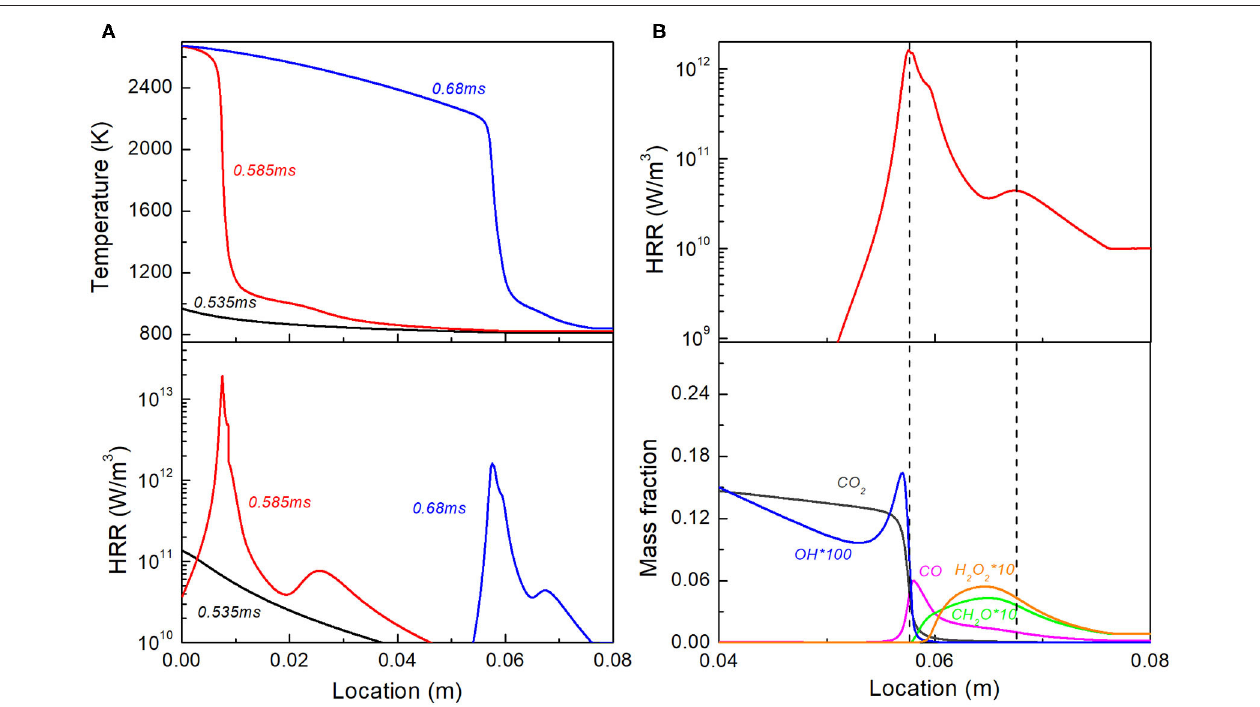
FIGURE 9 | (A) Temperature and heat release rate profile at selected time instants for Case 10; (B) Double peak heat release and profiles of representative species for reaction front at t =